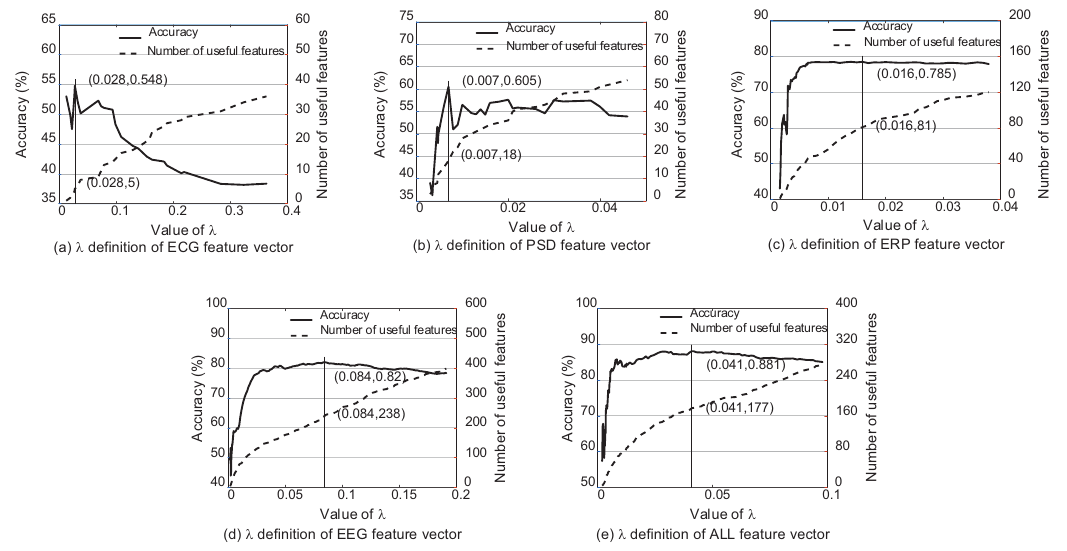
Figure 5. The classification accuracy using the single feature vectors (PSD feature vector, ERP feature vector, ECG feature vector) and fused vectors (EEG feature vector, ALL feature vector) according to λ based on k-NN (k =